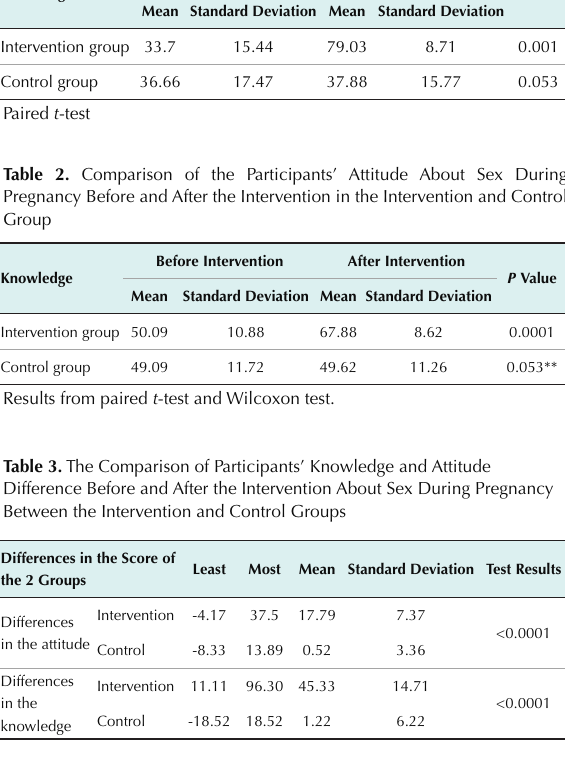
Table 1. Comparison of the Participants’ Knowledge About Sex During Pregnancy Before and After the Intervention in the Intervention and Control Group Knowledge